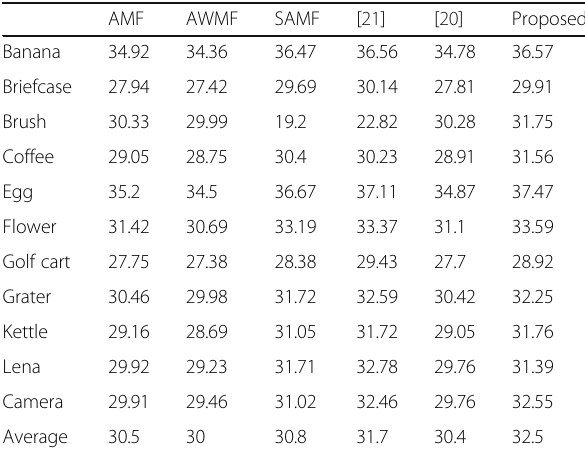
Table 7 MSSIM comparison for 30% noise